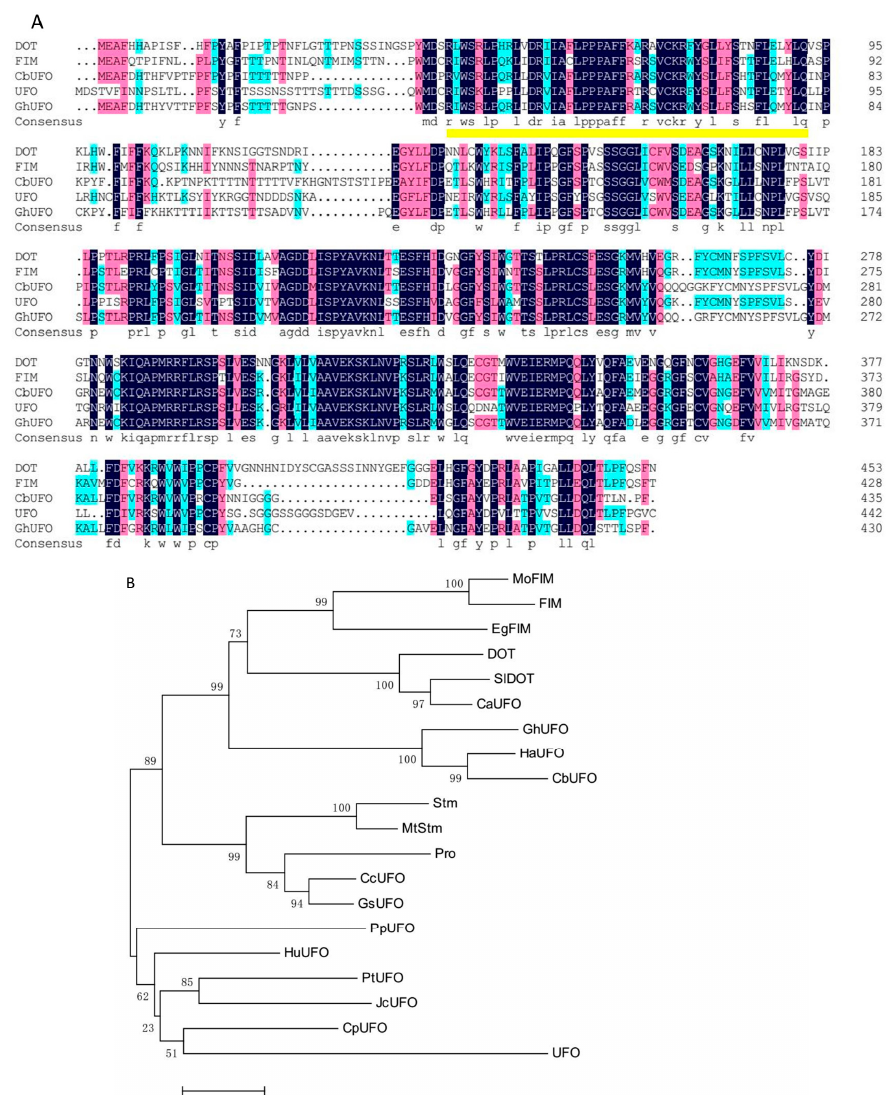
Figure 5. Multiple sequence alignment ( A ) and phylogenetic relationship ( B ) of CbUFO and UFO-like proteins. Identical amino acid residues in this alignment are shaded in blue, and similar amino acid residues are shaded in red. The F-box domain is indicated by a yellow underline. The protein sequences included in the analysis are GhUFO (Gerbera hybrid cultivar ANS10153.1), FIM (Antirrhinum majus bbm | 341836), DOT (Petunia × hybrida ACA61781.1), UFO (Arabidopsis thaliana OAP18214.1). ( B ) Phylogenetic relationship among FIM / UFO-like proteins. The protein sequences included in the analysis are HaUFO (Helianthus annuus XP_021982608.1), GhUFO (Gerbera hybrid cultivar ANS10153.1), MoFIM(MisopatesorontiumCAJ44131.1), FIM(AntirrhinummajusAAB31352.1), HuUFO hybridaACA61781.1), CpUFO(CaricapapayaXP_021891471.1), CcUFO(CajanuscajanXP_020232435.1),